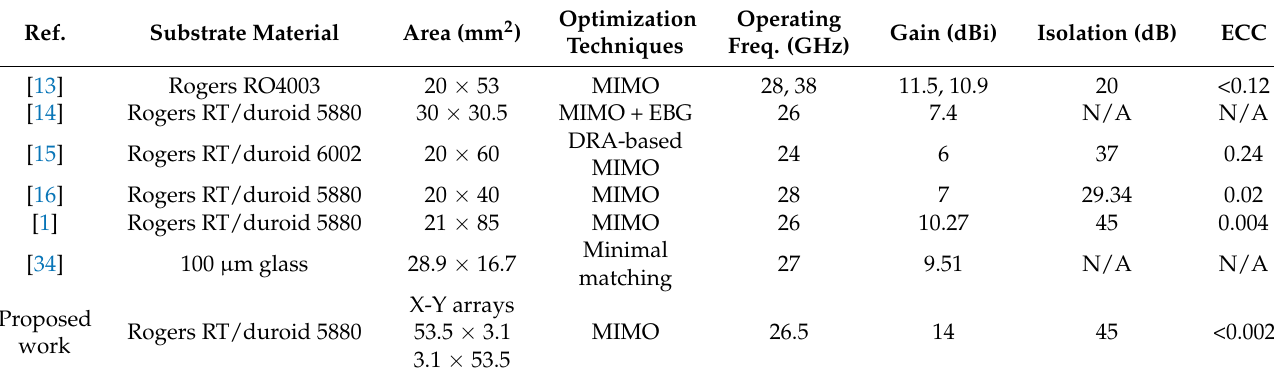
Table 3. Comparison with other published